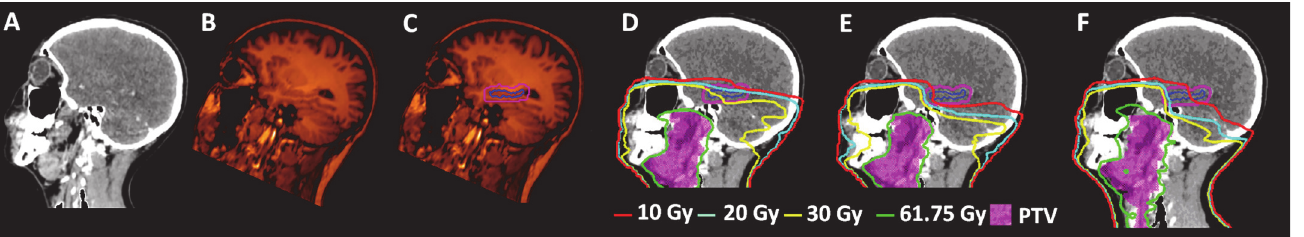
Fig 1. Hippocampal delineation and treatment planning. Sagittal views of (A) the RT planning CT; (B) the registered T1w image; (C) the T1w image with the left hippocampus and left hippocampal PRV shown; (D) standard clinical, (E) HSRT and (F) BSRT HNC treatment plans. In C, D, E, and F the hippocampus and hippocampal PRV are shown as blue and pink contours